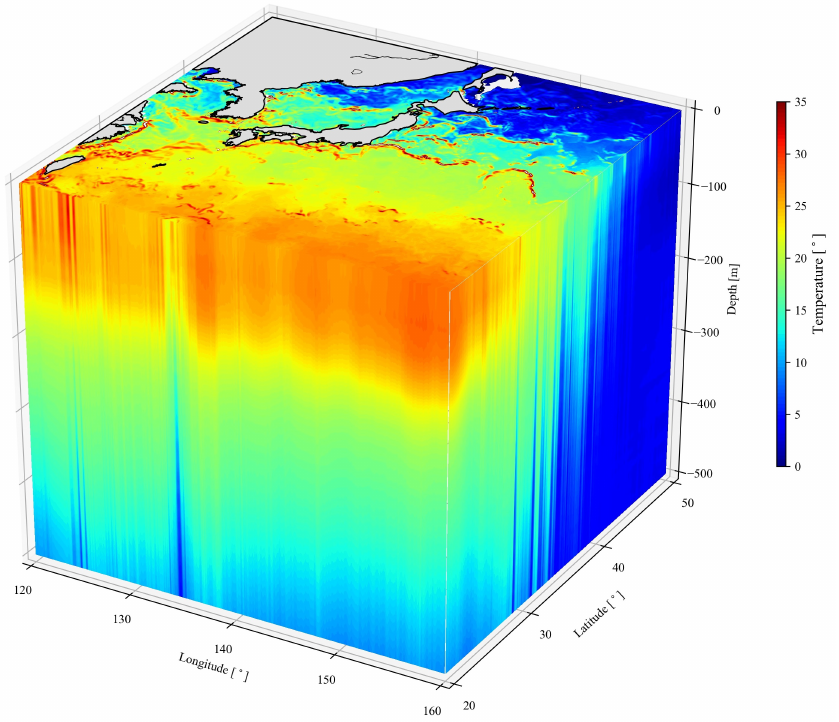
Figure 9. Three-dimensional representation of the reconstructed temperature using model 8 with input of daily SST and SLA on 1 January